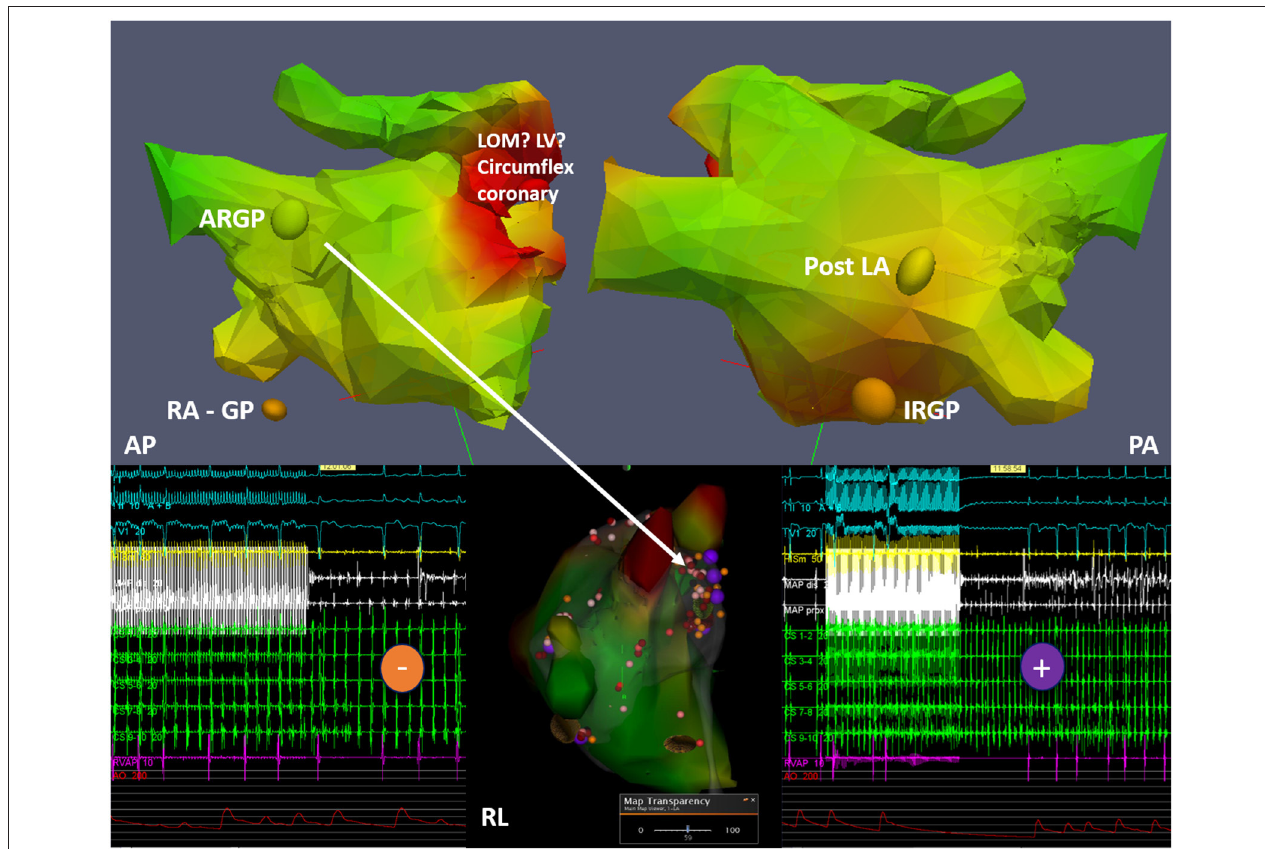
FIGURE 8 | Example of 123I -MIBG imaged-guided ganglionated plexus (GP) modulation in a patient with paroxysmal atrial fibrillation. The top panels depict three-dimensional (3D) reconstructions from 123I -MIBG nuclear image merged with contrast computed tomography imaging with discrete uptake sites of 123I -MIBG demonstrated as colored spheres (ARGP, anterior right GP; IRGP, inferior right GP; RA GP, right atrial GP; post LA GP, located in the posterior LA wall). The middle lower panel shows the integration into the electroanatomical mapping system with the results of the high-frequency stimulation (HFS) shown as colored tags (purple, positive HFS effect with temporary AV block; orange, negative HFS effect). In addition to radiofrequency ablation at positive HFS sites, conventional isolation of the pulmonary veins is subsequently performed. Other abbreviations: AP, antero-posterior projection; PA, postero-anterior projection; RL, right lateral projection; LV, left ventricle; LOM, ligament of